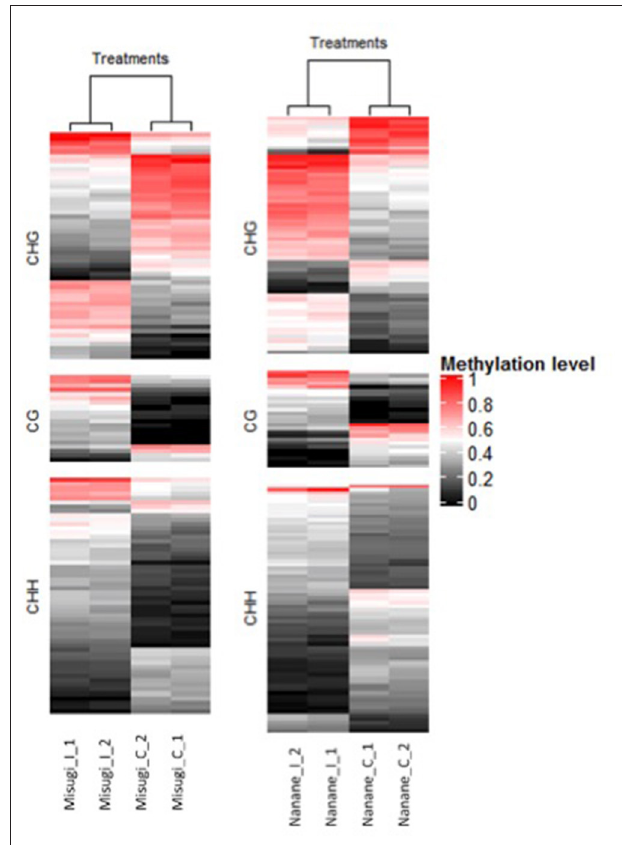
FIGURE 4 | Heatmap of methylation levels of 155 and 126 differentially methylated regions (DRMs) - associated genes, respectively, in B. rapa cultivars “Misugi” (susceptible) and “Nanane” (resistant) for control (_C) samples and infected (_I) samples with A. candida for replicate one (_1) and two (_2). Each line represents one DMR. Methylation level 1 means all the cytosines of a given context are methylated in the region.